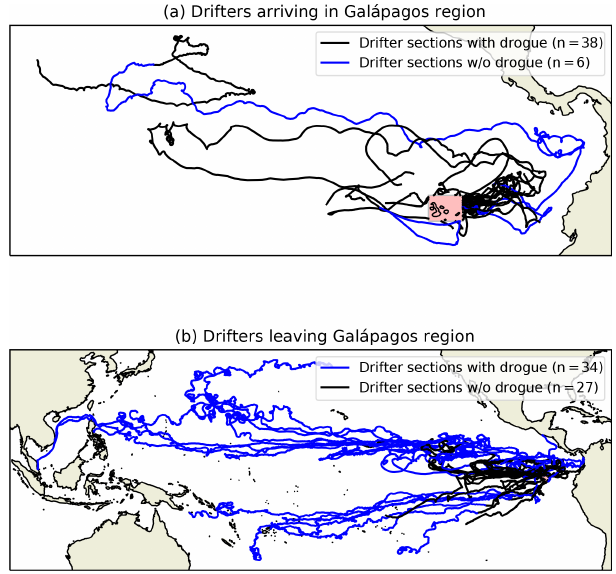
Figure 1. Trajectories of surface drifters in the real ocean from the GDP (Elipot et al., 2016). Panel (a) shows drifter trajectories before they arrive in the Galápagos region. Panel (b) shows drifters after they leave the Galápagos region. Black sections of the drifter trajec- tories indicate when the drifters still have their drogue attached, in the blue sections these drogues are